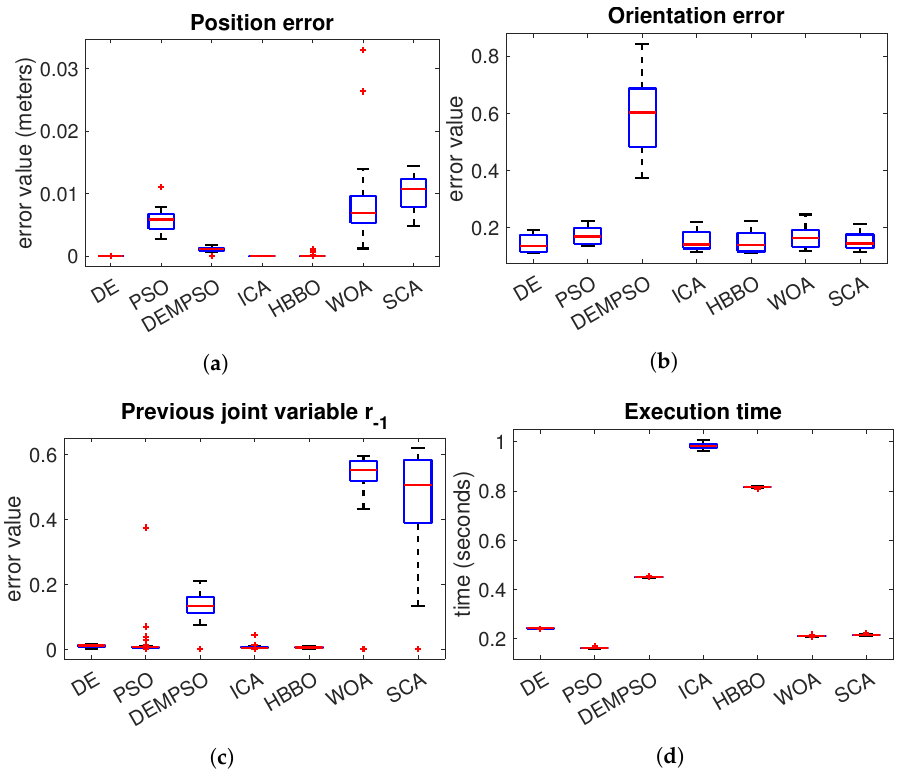
Figure 4. Circle path tracking results for the Youbot robot. ( a ) Youbot end-effector position error (5); ( b ) Youbot end-effector orientation error (15); ( c ) Youbot joint variables error (16); ( d ) Execution time for each point in the